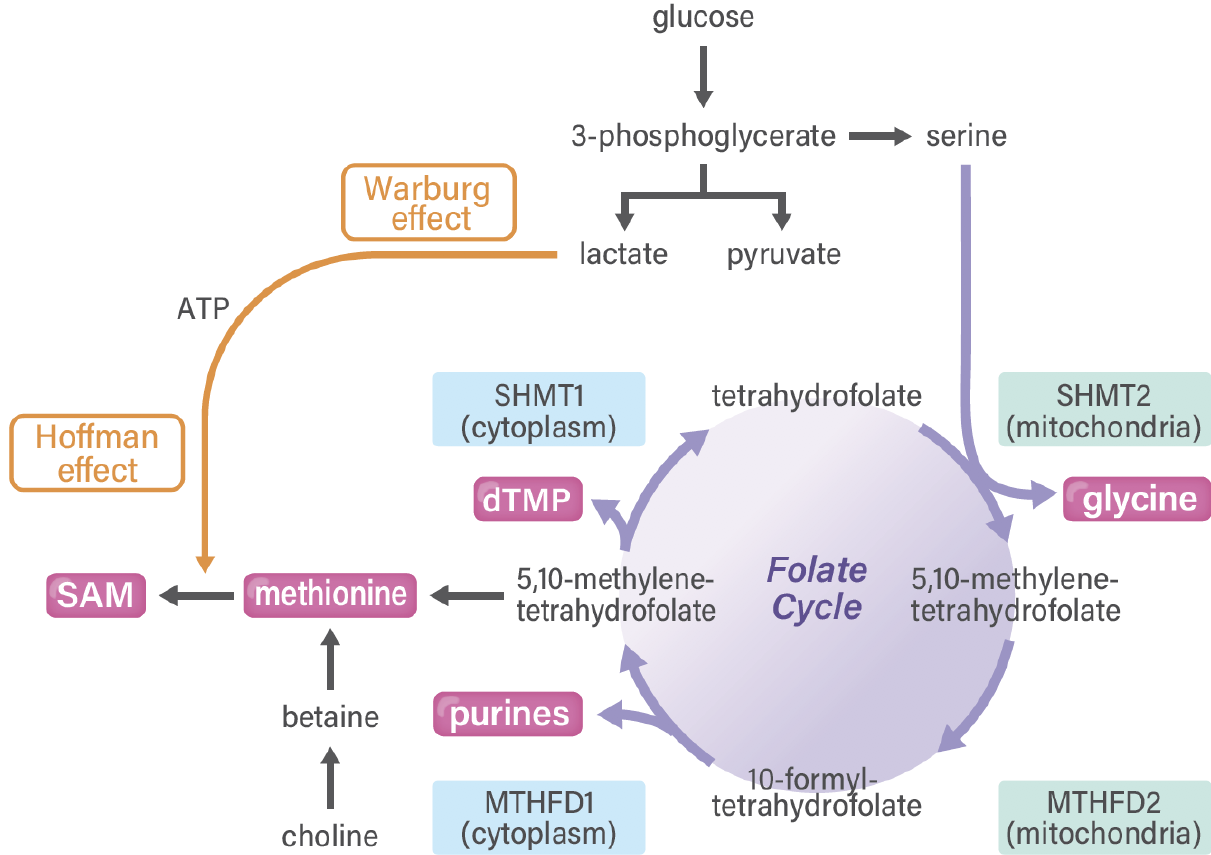
Figure 2. Folate cycle and SAM in cancer. The Warburg and Hoffman effects collaborate with each other via one-carbon metabolism. MTHFD and SHMT are druggable targets for cancer treatment. MTHFD, methylenetetrahydrofolate dehydrogenase; SAM, S-adenosylmethionine; SHMT, serine hydroxymethyltransferase.